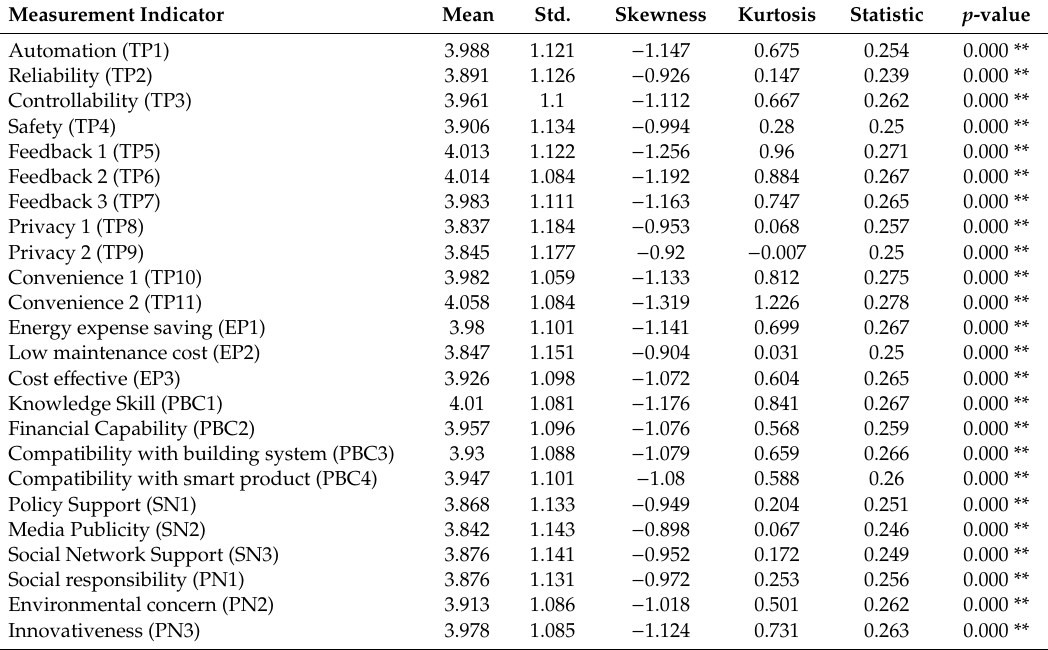
Table 4. Test result of normal